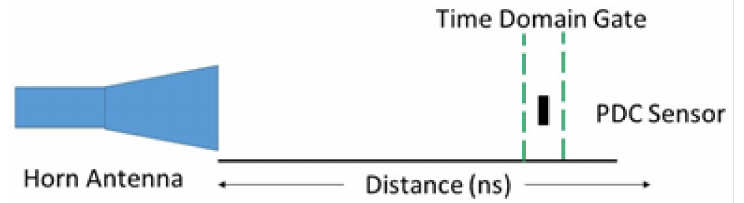
Figure 10. Time − domain gating filtering technique diagram of the experiment